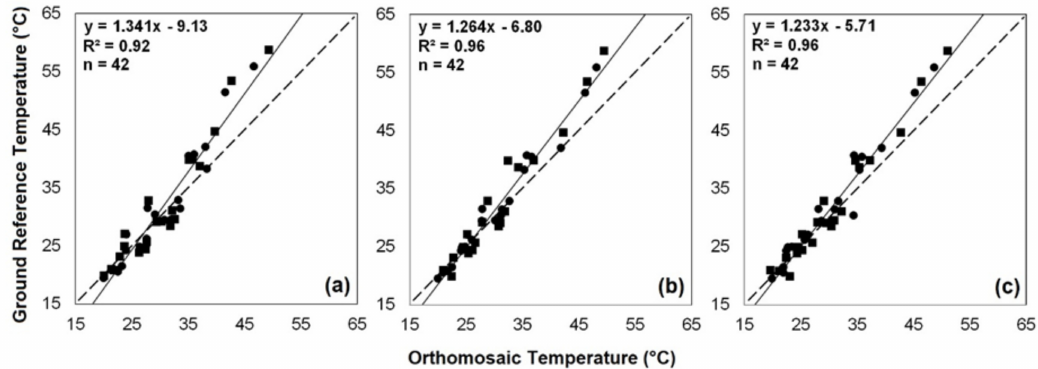
Figure 6. Linear regression models between the ground reference temperature and TIR temperature from orthomosaics obtained with the mosaic ( a ) and averaged ( b ) blending modes, and with blending disabled ( c ). Symbols indicate datasets from 65 ( • ) and 100 m ( (cid:4) ) flight altitudes. Dashed line = 1:1 line; solid line = linear regression line; p < 0.001 for all R 2 .